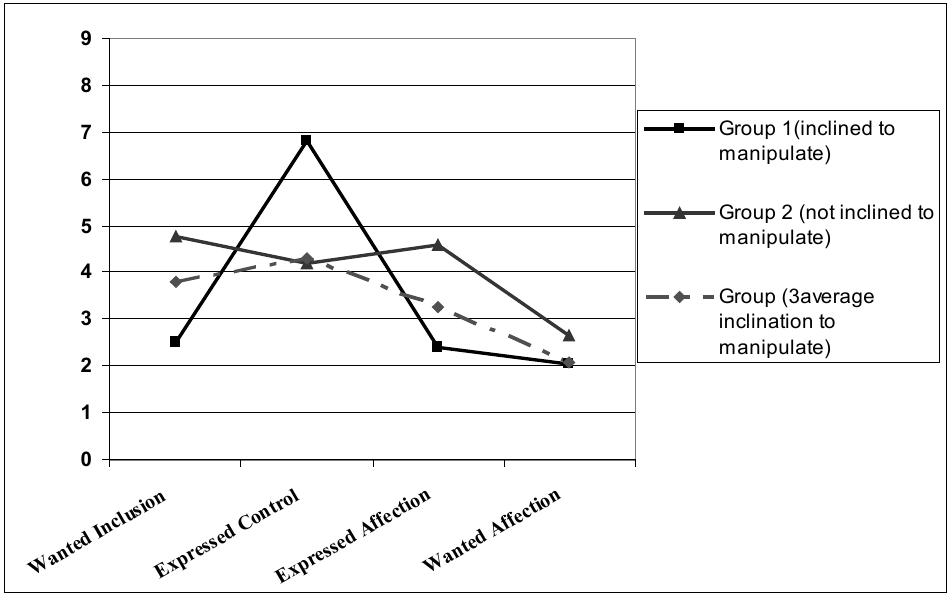
Fig. 3 Comparative diagram of the research results according to